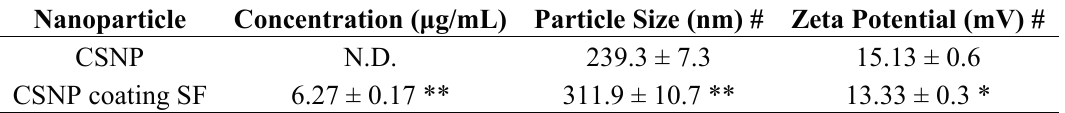
Table 1. Characterization of